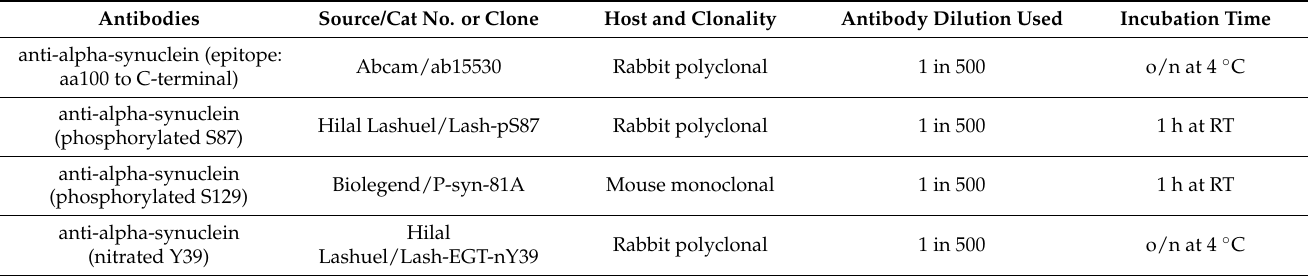
Table 2. List of antibodies used in the